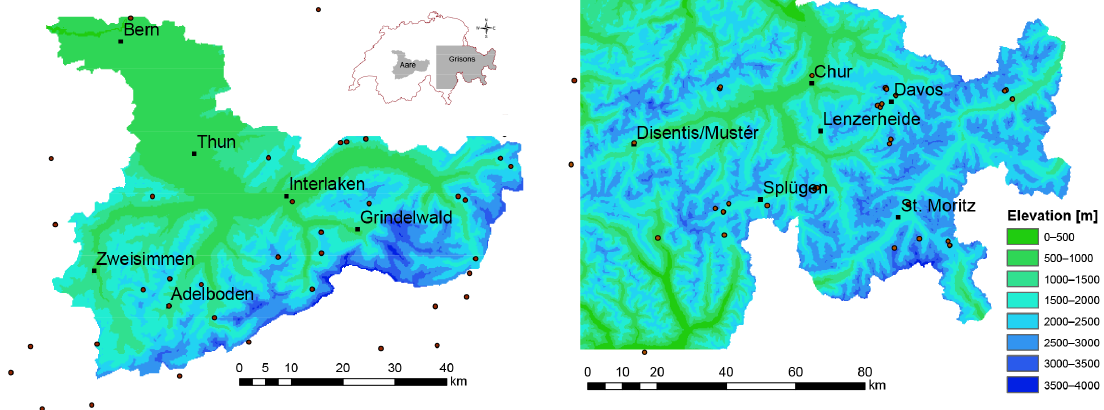
Figure 1. Elevations in the Aare (left) and the Grisons region (right). Weather stations used for simulations are marked with dots. The location of the two regions within Switzerland is shown in the red inset with the two grey